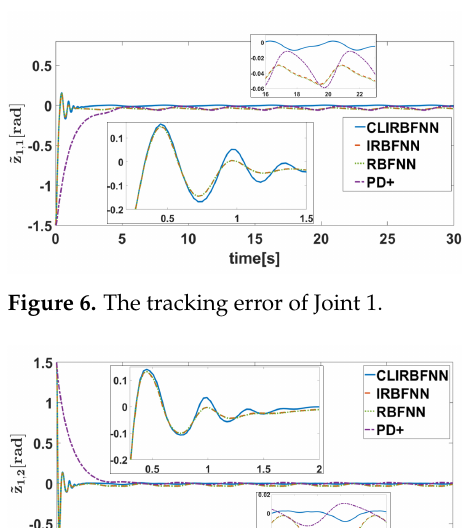
Figure 5. Error ˜ z 1,2 with different initial values.